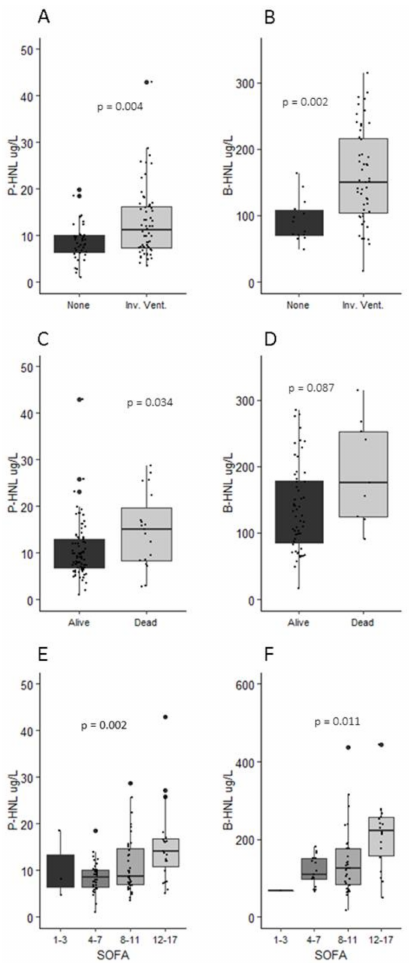
Figure 5. Human neutrophil lipocalin in plasma at admission and peak concentrations in whole blood during intensive care vs. invasive ventilation ( A , B ), 30-day mortality ( C , D ), and SOFA score ( E , F ). P-HNL Dimer at admission differentiated between survivors and non-survivors at 30 days, but peak B-HNL concentration did not ( p = 0.034 and p = 0.087). Those that were treated with invasive ventilation demonstrated higher mean concentrations of P-HNL Dimer and B-HNL ( p = 0.004 and p = 0.002). P-HNL Dimer and B-HNL could both separate between patients with high and low SOFA scores with increasing HNL concentrations associated with higher SOFA scores during ICU stay ( p = 0.002 and p =